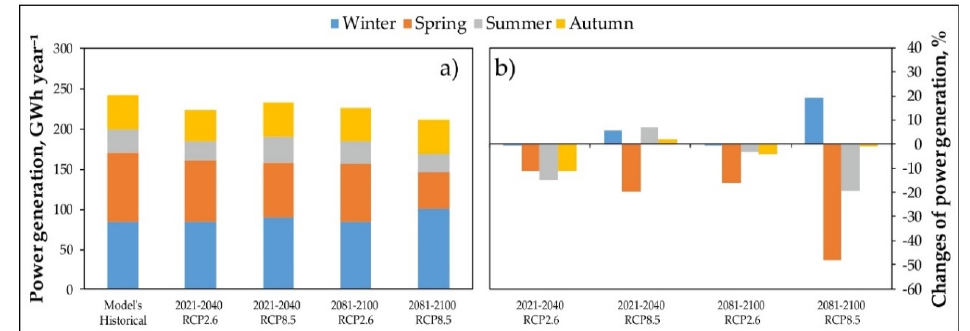
Figure 6. Projections of kinetic resources of the main Lithuanian rivers (except the Nemunas and Neris) in the near and far future in different seasons ( a ) and resource changes in comparison with 1986–2005 ( b ).